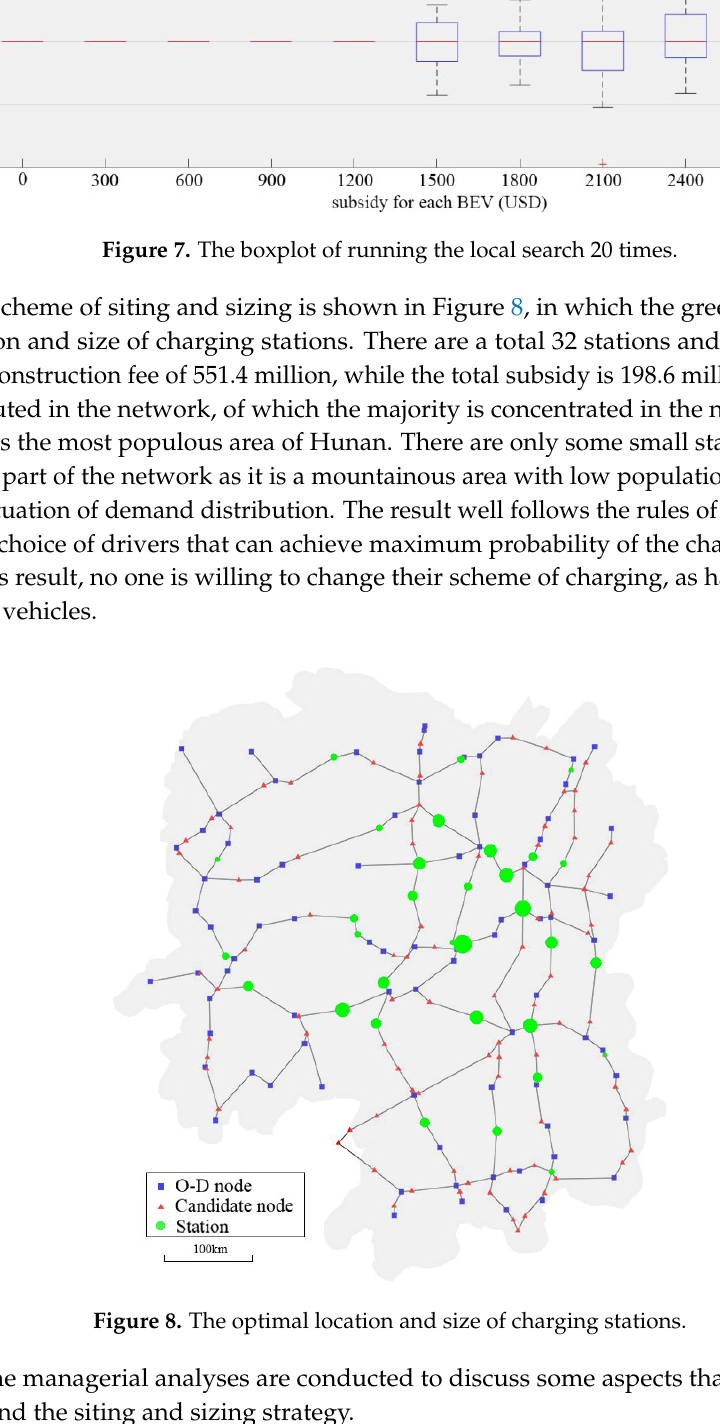
13 of 22 Figure 6. The computing times of the local search algorithm under different subsidies.